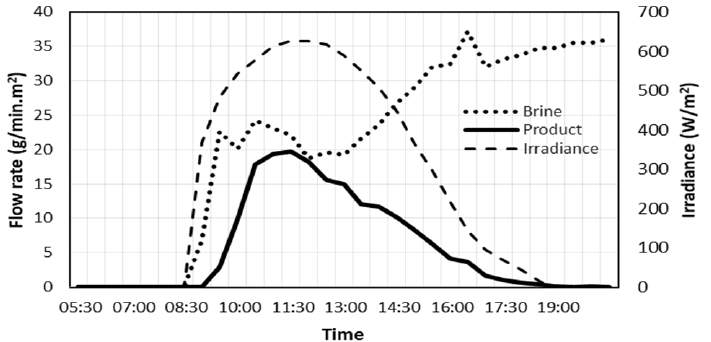
Figure 13. Irradiance and mass flow rate of Brine and Product of the MSS prototype-2 for one day of operation (Jun 15th).